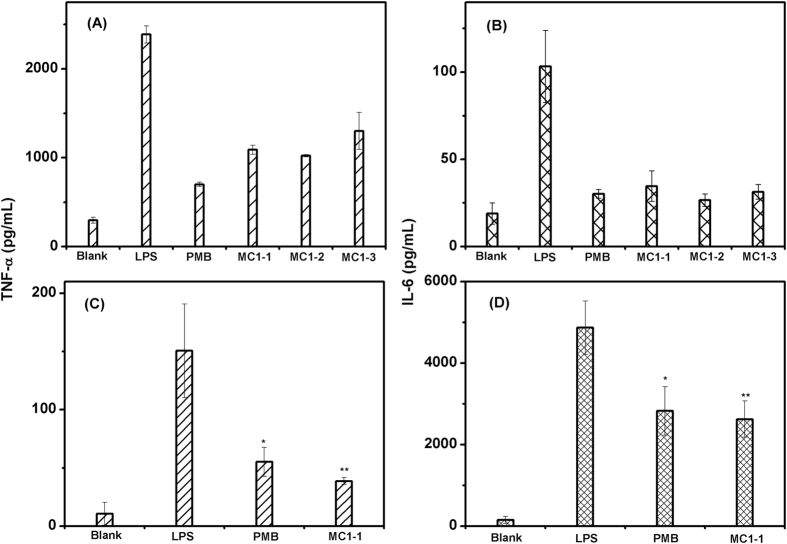
The production of TNF-α and IL-6. Raw 264.7 cells were stimulated with LPS and administrated by MC1-1, MC1-2 and MC1-3 for 24 h (A and B) and the inhibition of LPS-induced TNF-α and IL-6 release in endotoxemia mice by MC1-1 (C and D). The concentration of TNF-α and IL-6 was measured by ELISA. The numbers above the bars represent the average inhibition as a result of the peptides treatment and the standard errors. Compared with the LPS-challenged group, significant difference (p < 0.05) is indicated by an asterisk (*), and extremely significant difference (p < 0.01) is indicated by double asterisk (**).